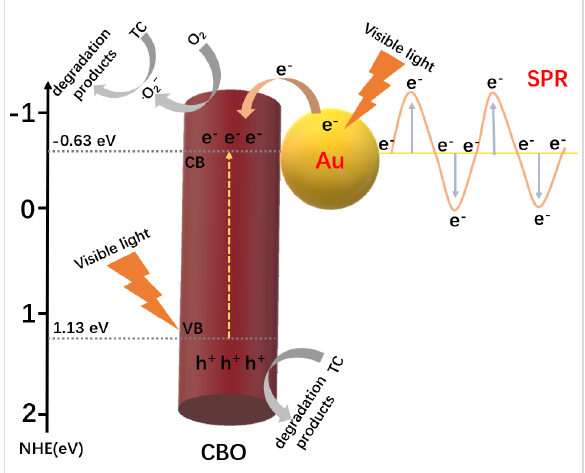
Figure 9: Possible photocatalytic reaction mechanism of the 0D/1D Au/CBO heterojunction photocatalyst during TC degradation under visible-light